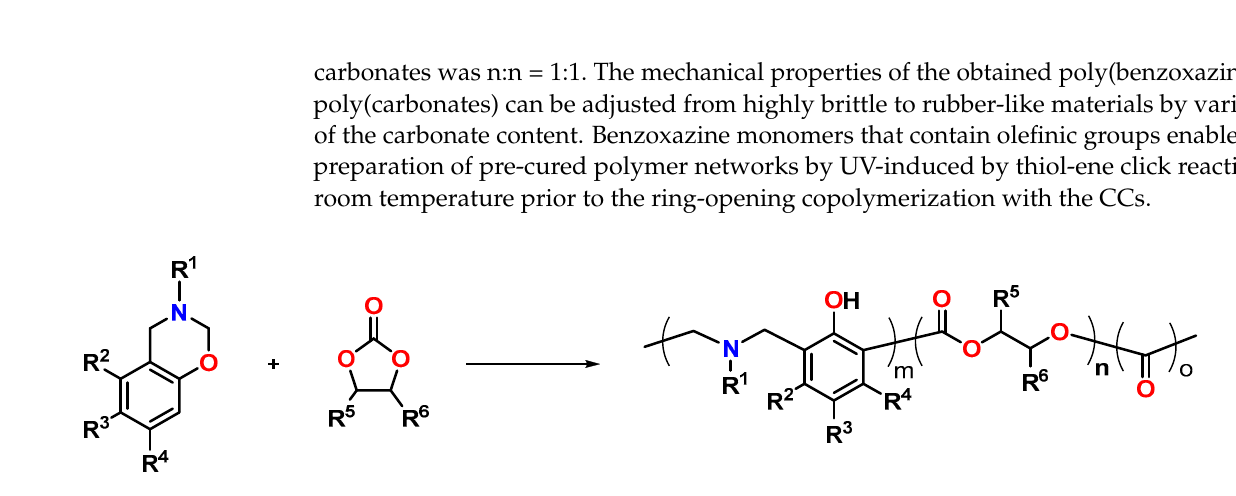
Figure 26. Schematic representation of the ring-opening copolymerization of benzoxazines and CCs.